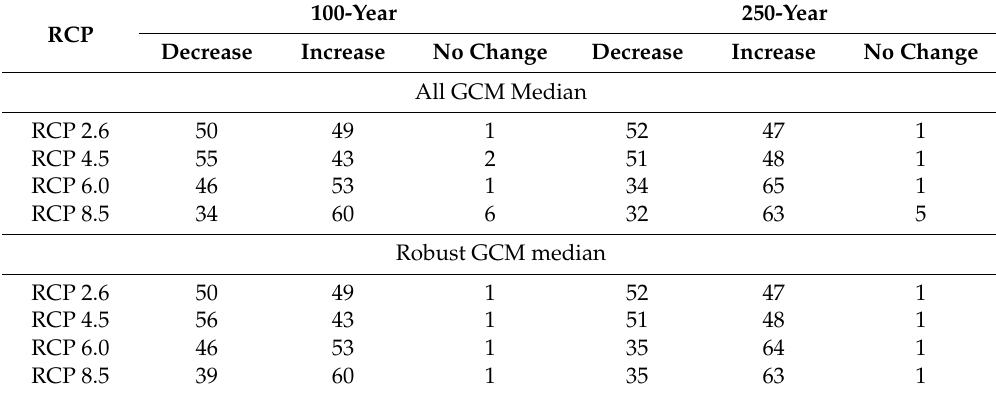
Table 1. Sign of change in flooding frequencies projected for 100 most populous Canadian cities.